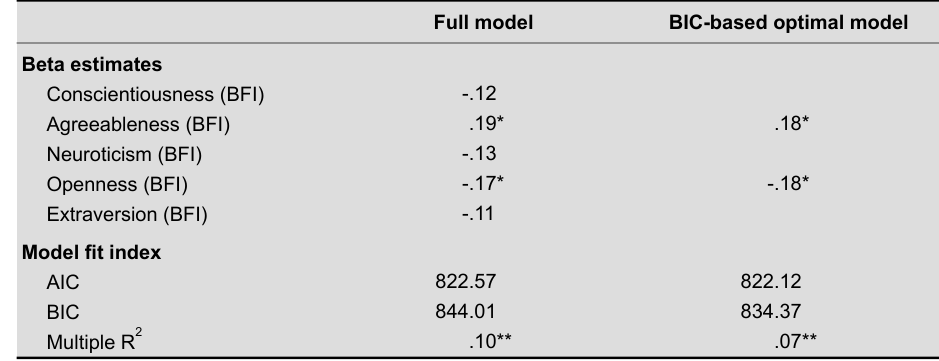
Regression Results for Predicting Centrality of Visual Aesthetic Products - Value, Using glmulti to Exhaustively Fit All Possible Models